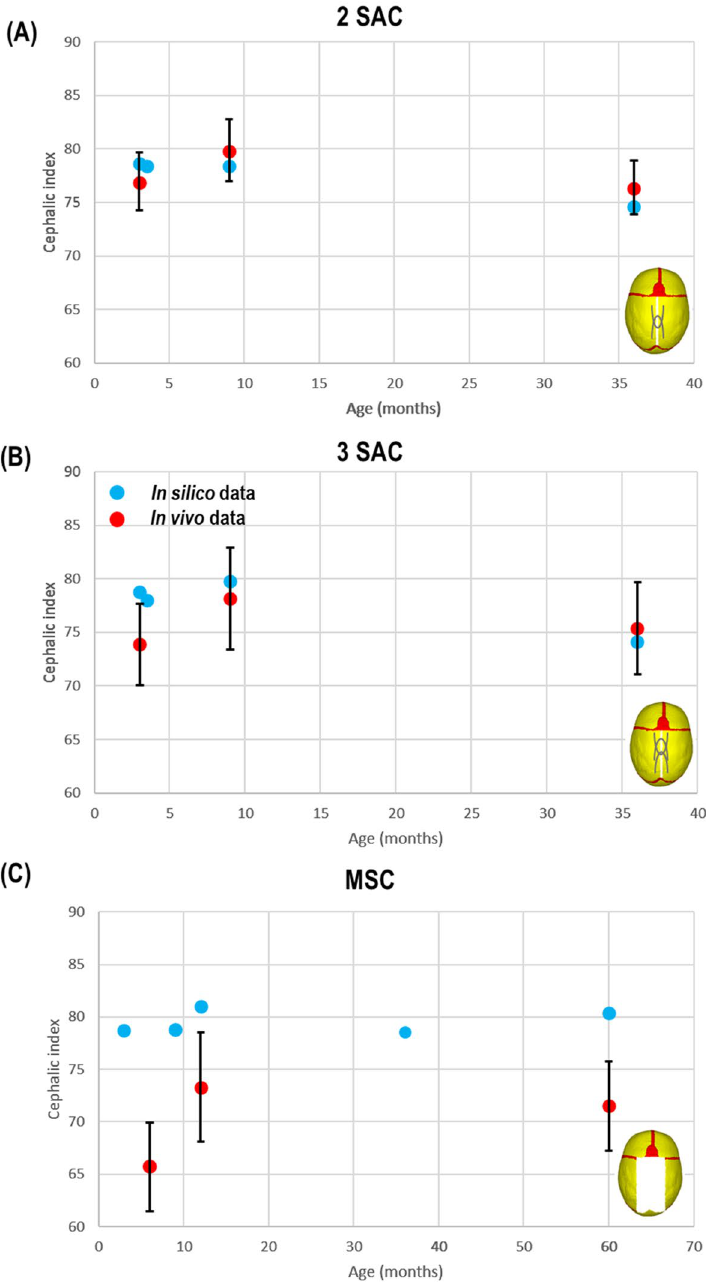
Figure 2. Predicted vs. in vivo cephalic index data with SD. Showing 2 SAC ( A ), 3 SAC ( B ) & MSC outcomes ( C